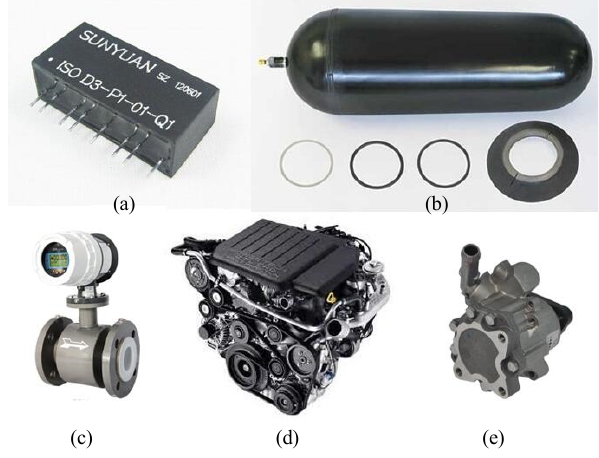
Figure 6. Main experimental equipment. ( a ) transmission isolator, ( b ) Msensor, ( c ) magnetoelectric sensor, ( d ) engine, and ( e ) hydraulic pump/motor.